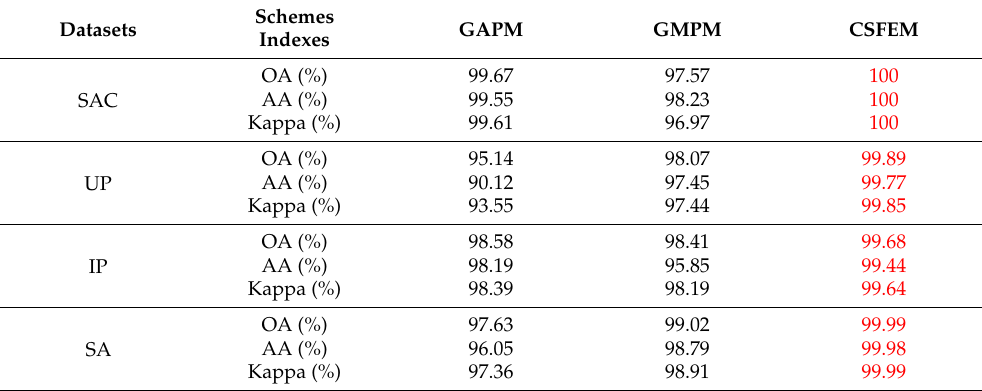
Table 10. Effectiveness analysis of CSFEM on the four experimental